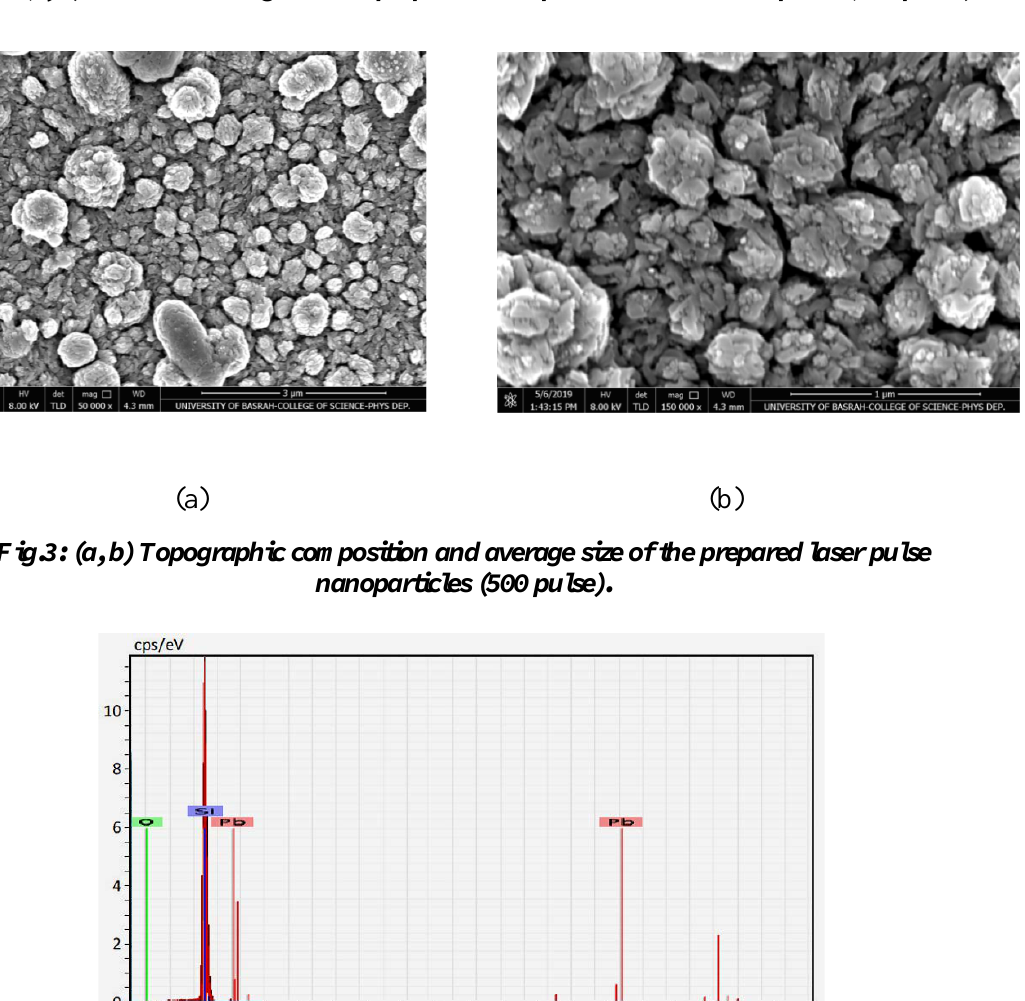
Fig.2: (a, b) 2D and 3D images of the prepared nanoparticles of the laser pulse (500 pulse).